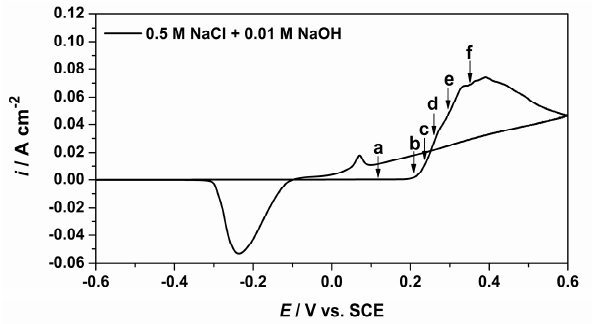
Figure 9. The cyclic voltammogram of copper in 0.5 M NaCl + 0.01 M NaOH solution.